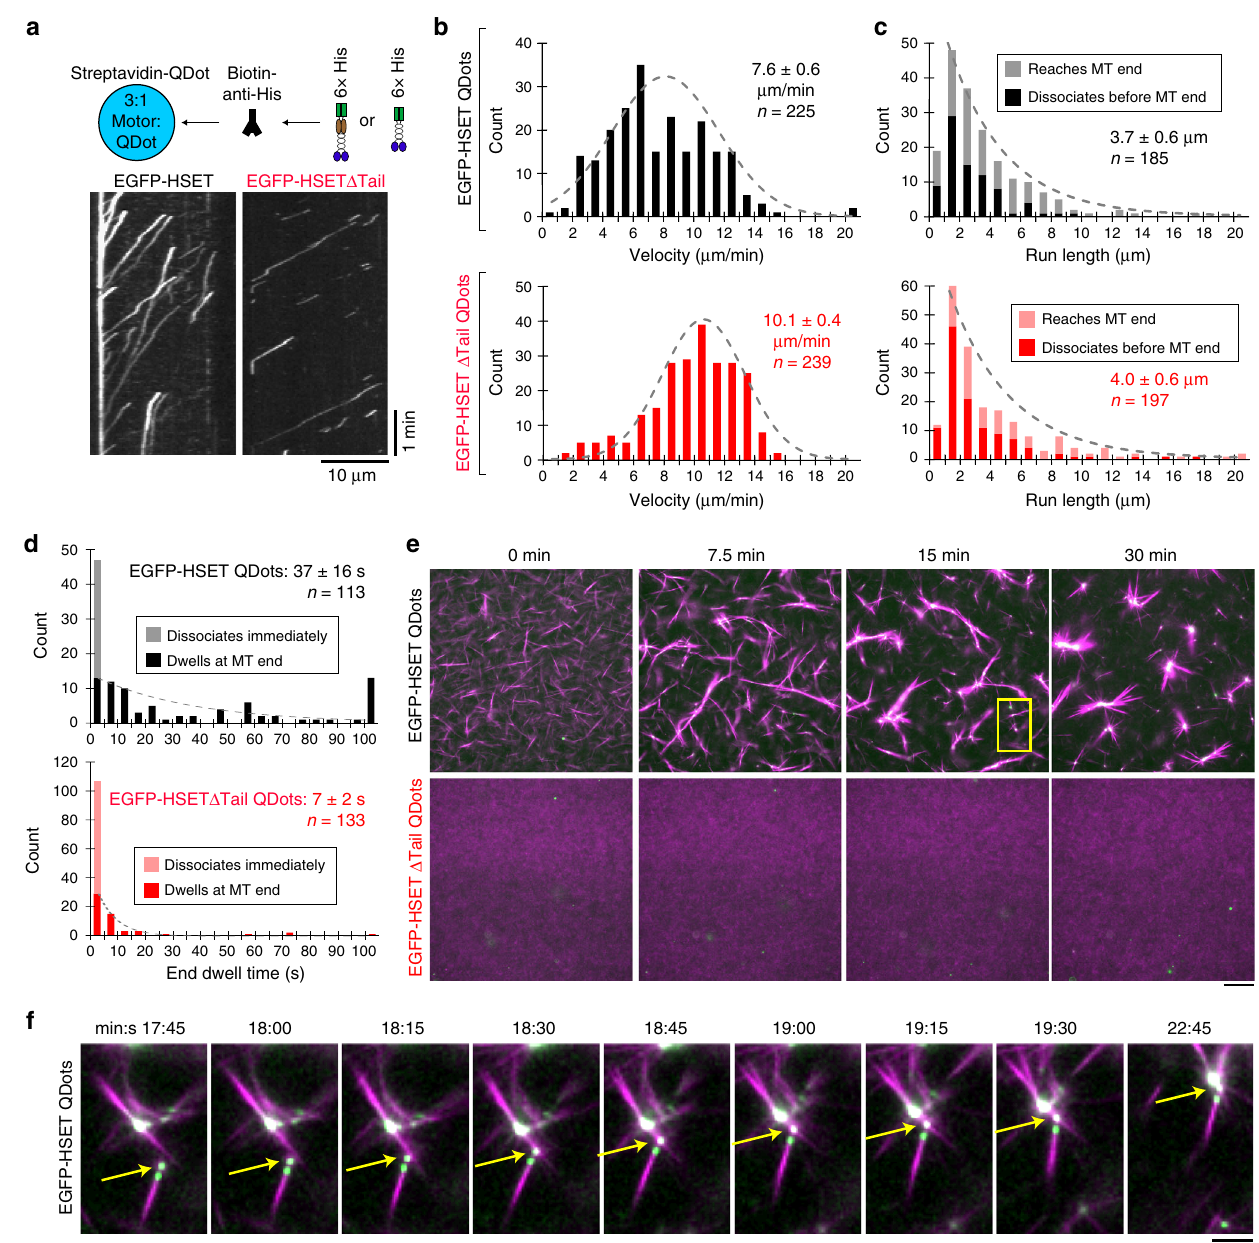
Fig. 5 Multiple HSET motors conjugated to quantum dots drive self-assembly of GMPCPP-MTs into asters. a EGFP-HSET or EGFP-HSET Δ Tail was conjugated to streptavidin-QDots via the N-terminal 6× His-tag and a biotin anti-His antibody at a 3:1 ratio and visualized via TIRF. Representative kymographs of EGFP-HSET-QDots (left, 1 nM EGFP-HSET: 0.33 nM QDot) and EGFP-HSET Δ Tail-QDots (right, 0.5 nM EGFP-HSET Δ Tail: 0.17 nM QDot) are shown ( x -scale, distance, 5 µ m; y -scale, time, 10 s). b – d Velocities ( b ), run lengths ( c ), and end dwell times ( d ) for the indicated constructed conjugated to QDots at a 3:1 ratio (EGFP-HSET, black, EGFP-HSET Δ Tail, red) were determined by kymograph analysis and plotted as histograms for the population. Data are reported as the mean values (insets) from CDF fi tting ± the 95% CI from bootstrapping for the indicated n particles from 2 independent experiments, where N ≥ 4 movies for each condition. Populations for EGFP-HSET-QDots (black, upper) and EGFP-HSET Δ Tail-QDots (red, lower) are shown. For run length/end dwell times, particles reaching the end of MTs/dissociating immediately (<1 frame) are color-coded on the histograms. e Self- organization of GMPCPP-stabilized MTs by EGFP-HSET-QDots and EGFP-HSET Δ Tail-QDots. Alexa594-labeled GMPCPP-MTs (10% labeled, 1 µ M tubulin in polymeric form, magenta) were mixed in assay buffer with the indicated motor-QDot complexes (21:7 nM motor :QDots, green) and monitored by time- lapse microscopy at 37 °C. The yellow box indicates the fi eld of view depicted in f . Technical replicates were repeated n ≥ 3 times for each condition, and representative images are shown. Scale bar, 50 µ m. f Zoomed-in view of the indicated fi eld. The yellow arrow indicates EGFP-HSET-QDots that have accumulated on the minus end of an MT bundle. Time is indicated in min:s. Scale bar, 10 µ generate a HeLa cell line that inducibly overexpresses EGFP- (non-MT) tubulin in cells. We investigated this hypothesis by HSET. By immunoblotting, we observed that EGFP-HSET changing the relative concentrations of both HSET and soluble (non-MT) tubulin during mitosis. To increase HSET protein levels, we used recombination-mediated cassette exchange 35 to